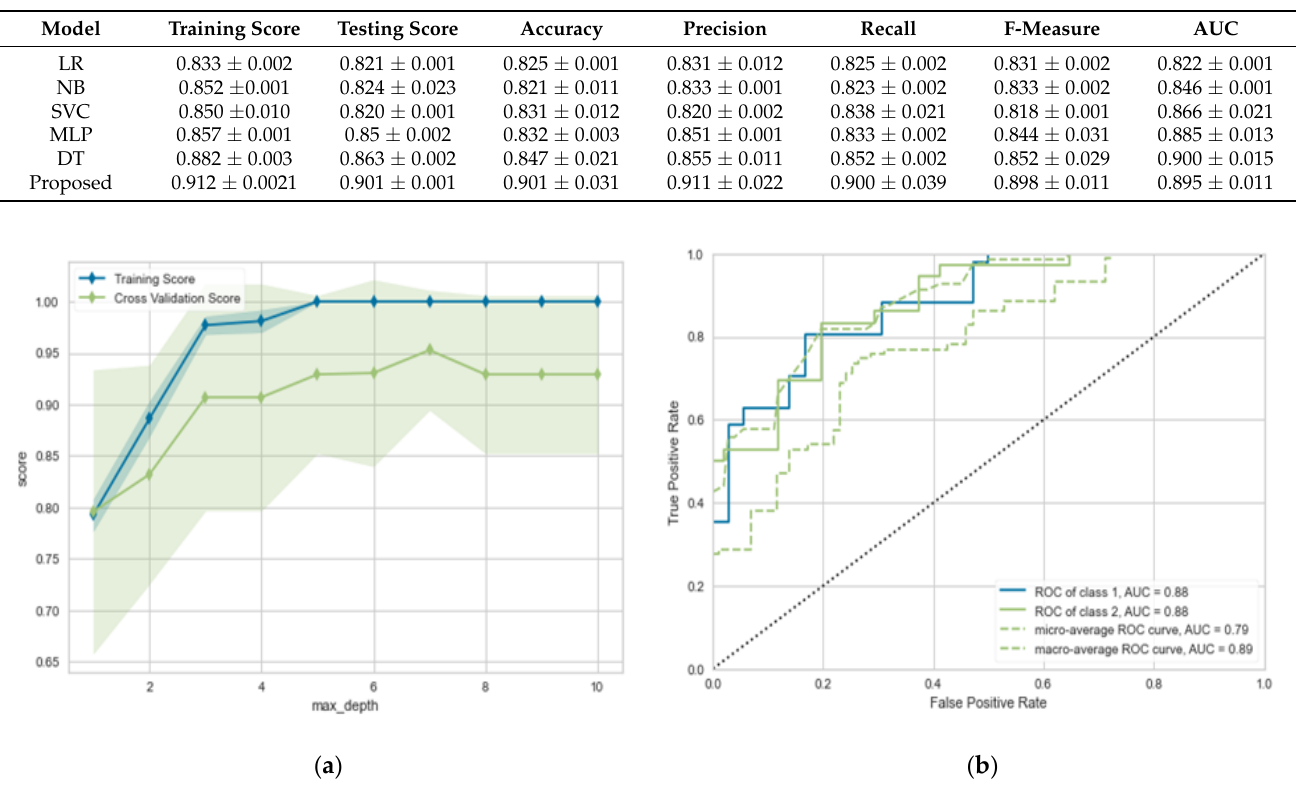
Figure 6. ( a ) Learning curve for the proposed model; ( b ) validation curve for proposed model (prognosis after 3 months).